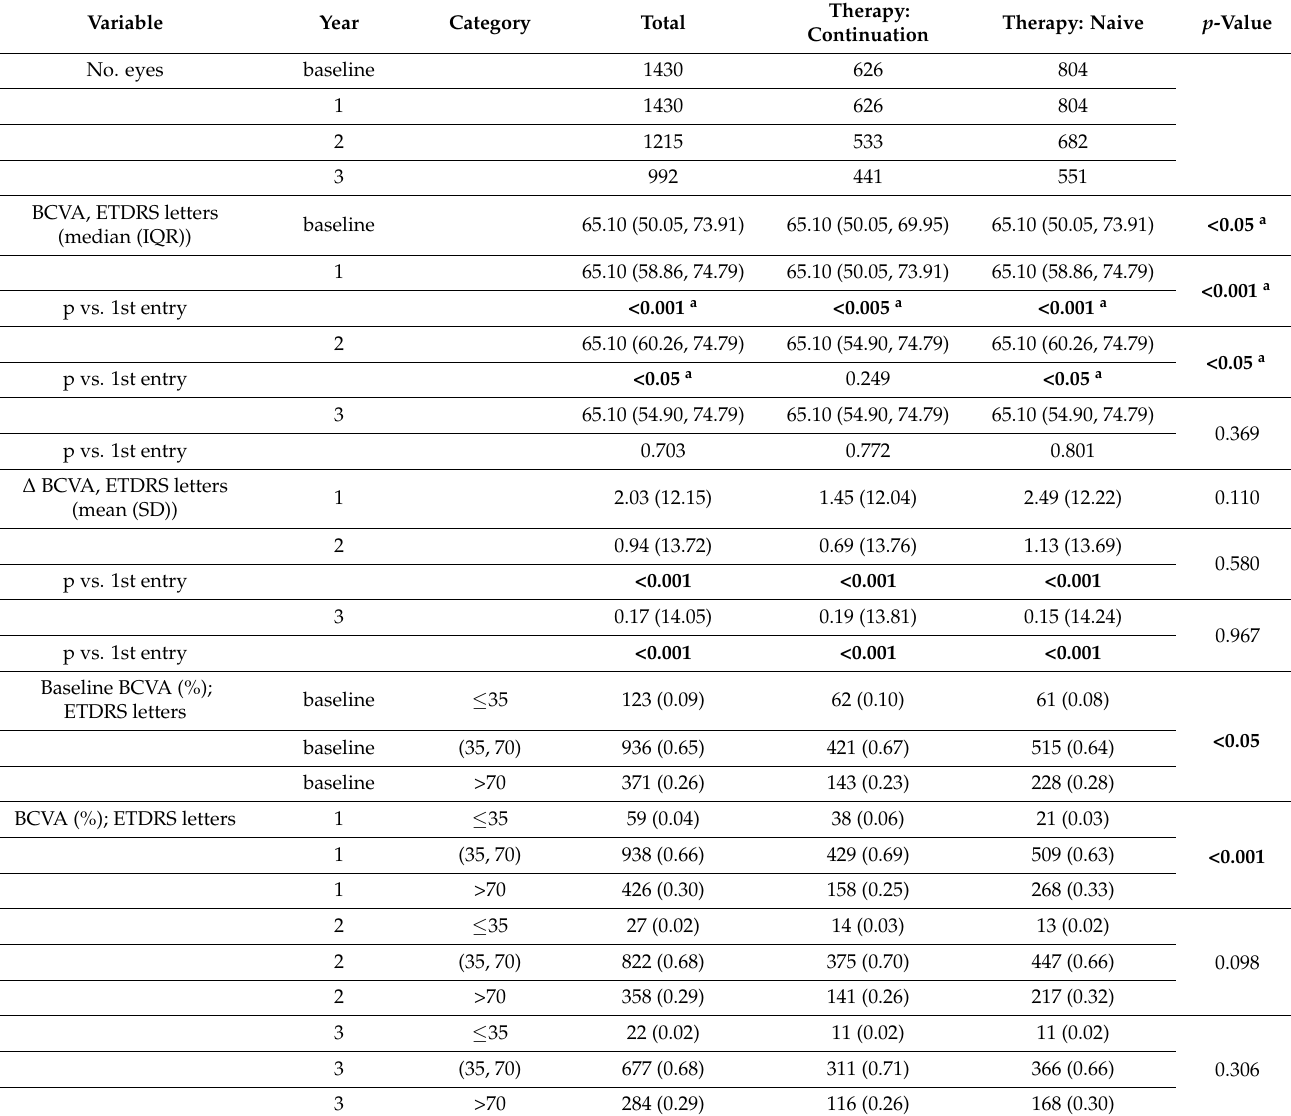
Table 2. Patients’ functional